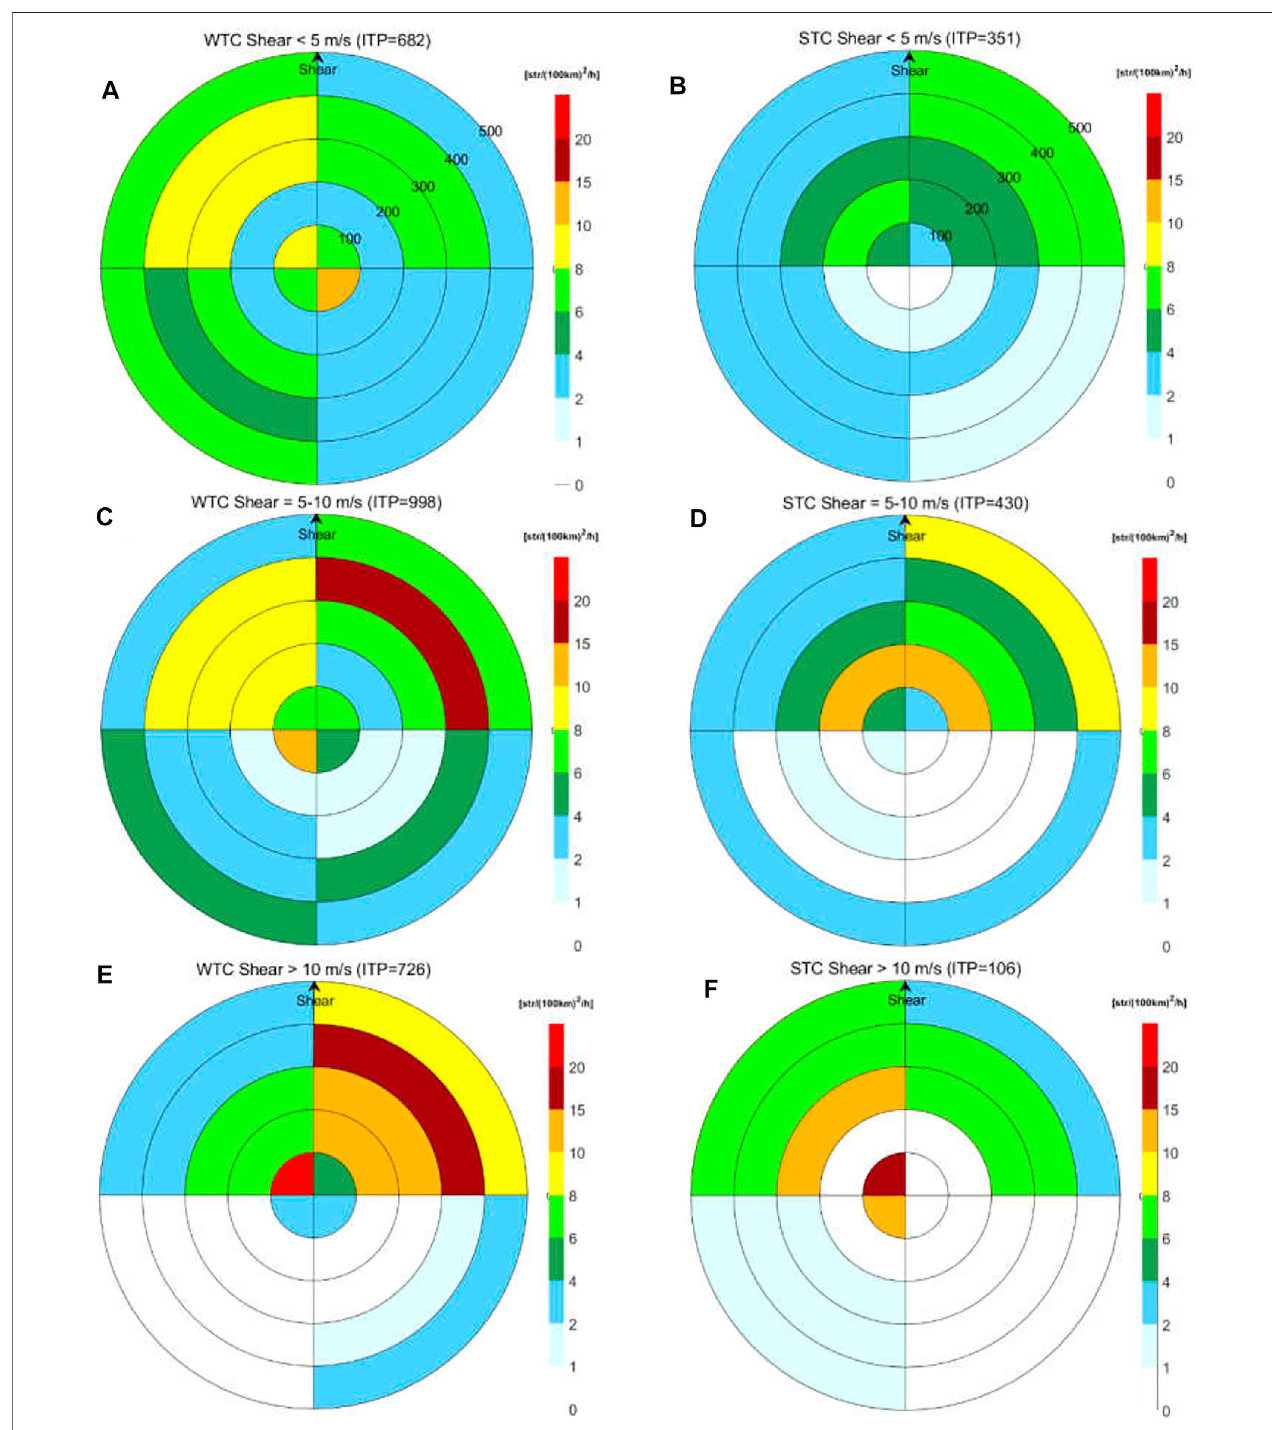
FIGURE 10 | Lightning asymmetry as a function of shear magnitude in WTCs and STCs. (A,B) : low shear ( < 5 m s − 1 ), (C,D) : moderate shear (5 – 10 m s − 1 ), (E,F) : high shear ( > 10 m s − 1 ).